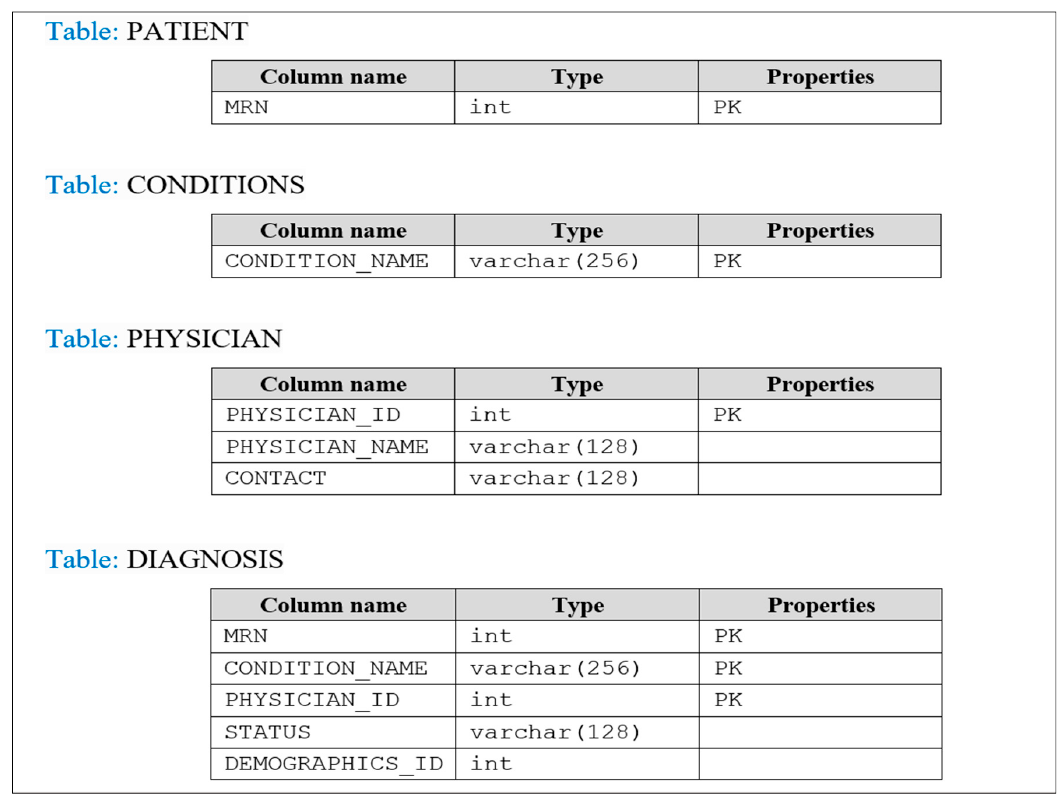
Figure 9. Converting the logical schema to physical model/tables.